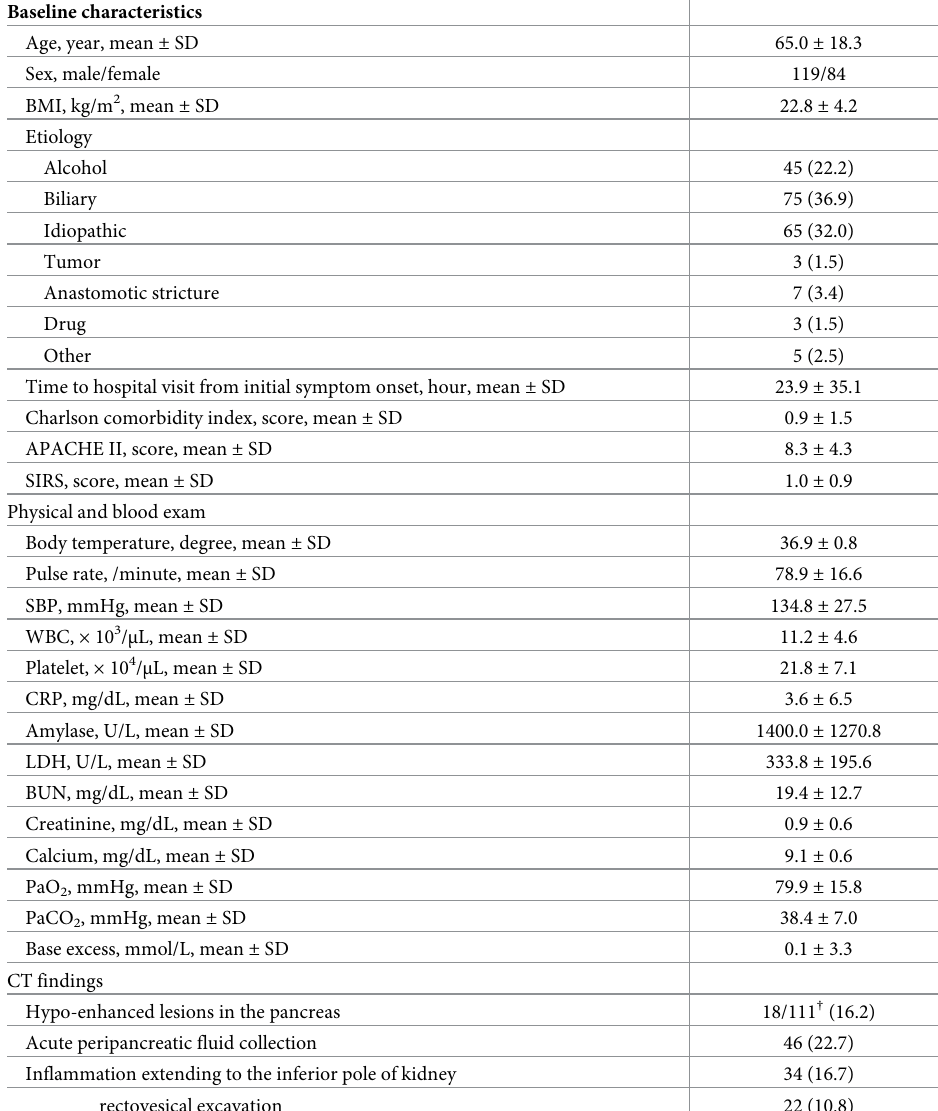
Table 1. Patient baseline characteristics on admission (n =